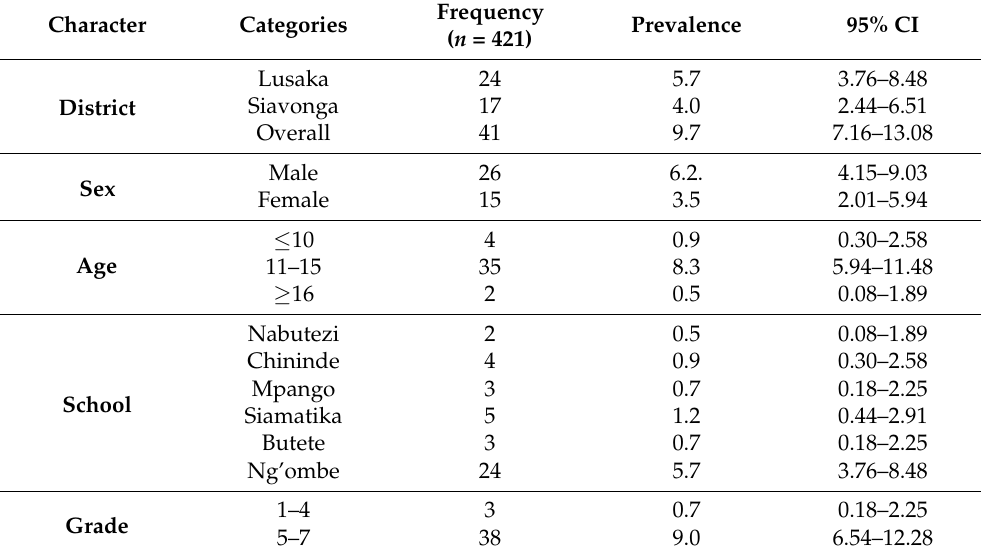
Table 2. Prevalence of schistosomiasis across sex, age, schools and school grades.